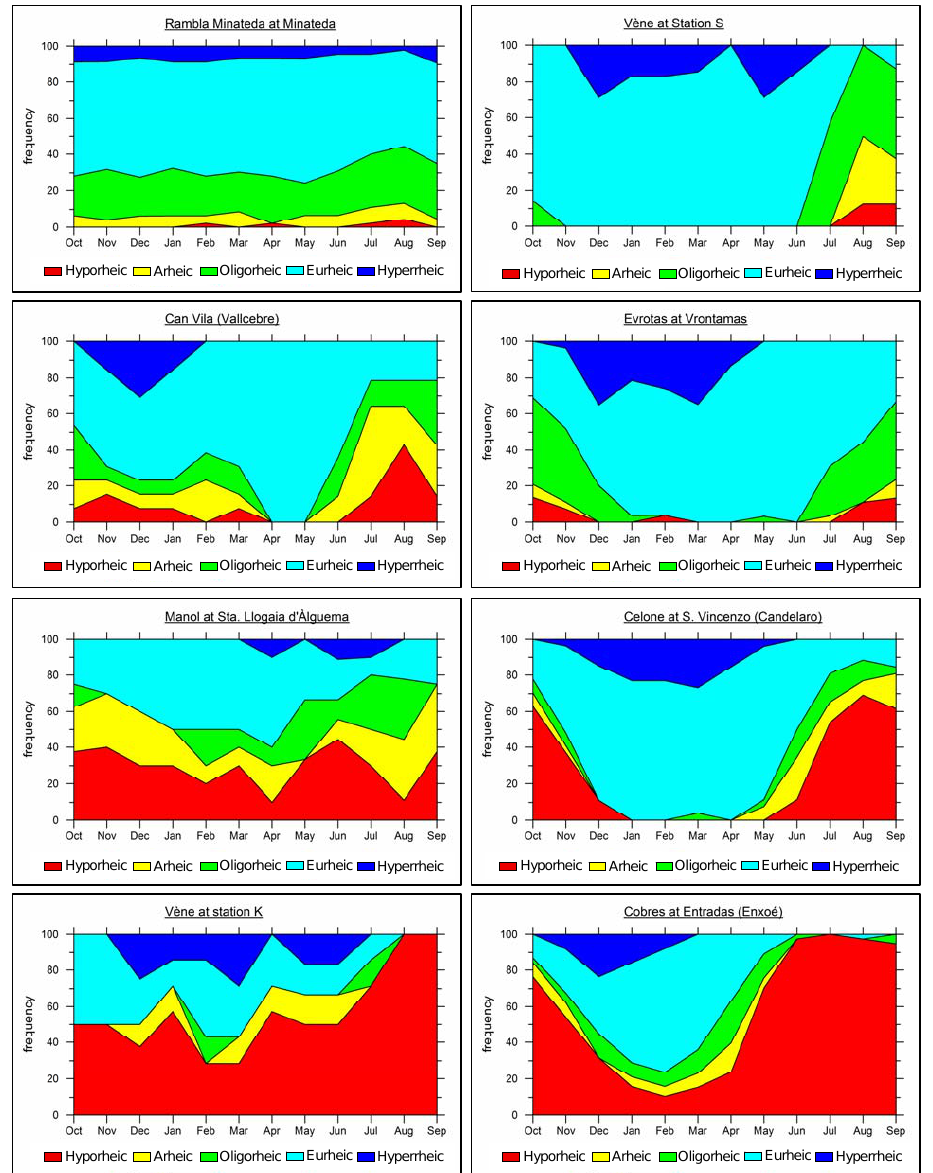
Fig. 5. Aquatic states frequency graphs for the eight main stream gauging stations in Fig. 1 and Table 1.